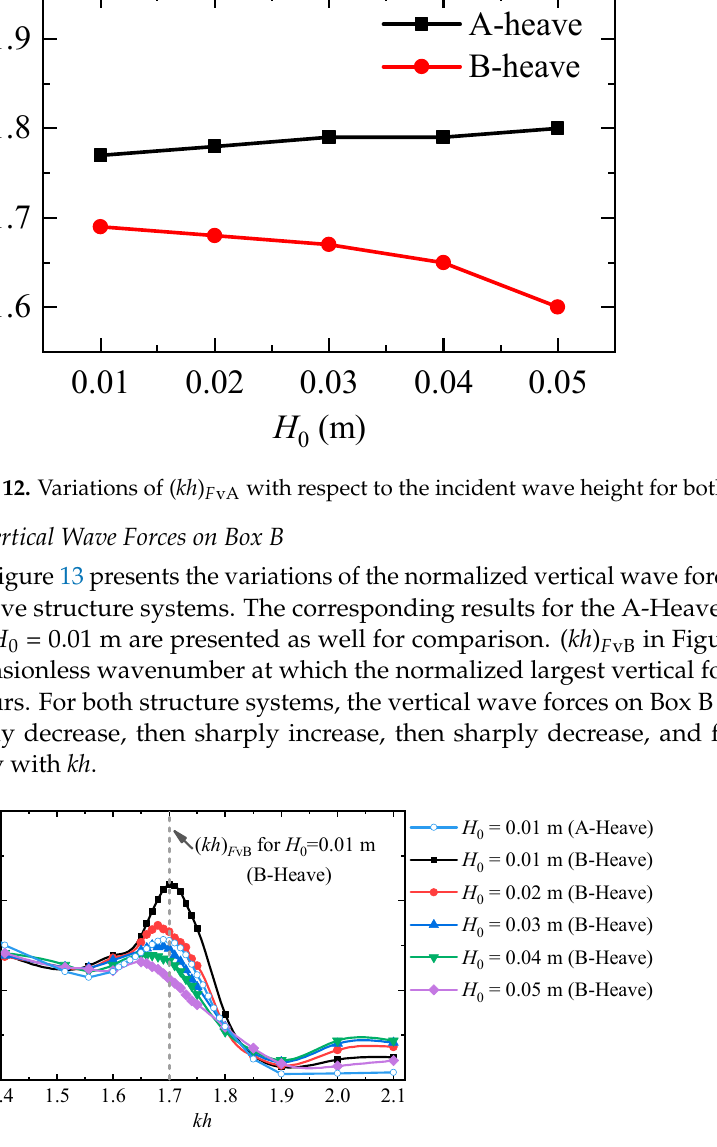
Figure 11. Variations of the normalized largest vertical wave force on Box A, [ F vA /( ρ ghA 0 W )] max , against the incident wave height.